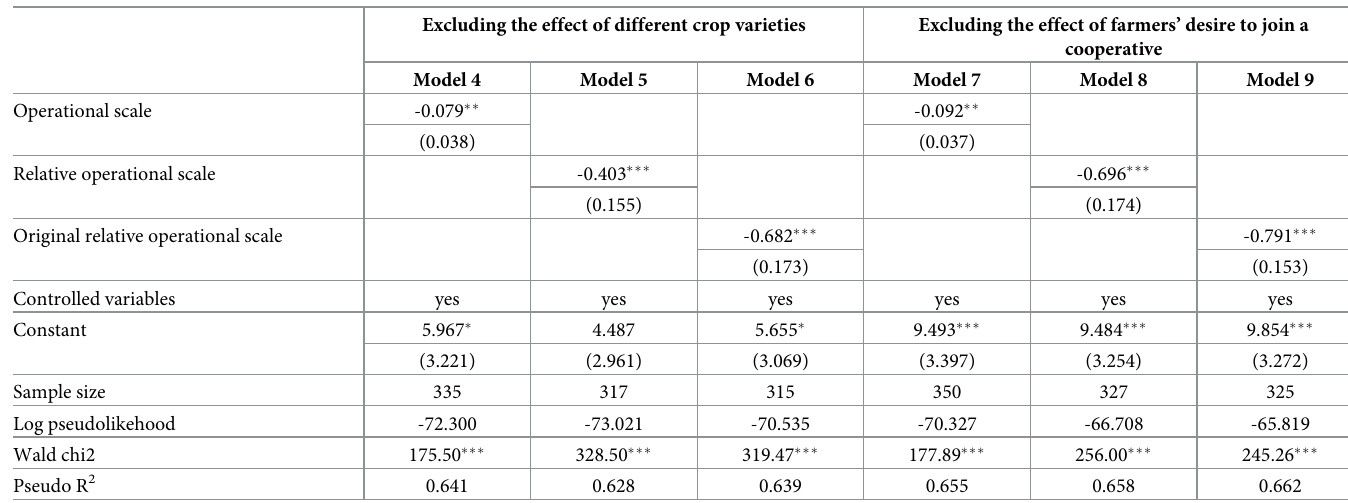
Table 6. Results of robustness